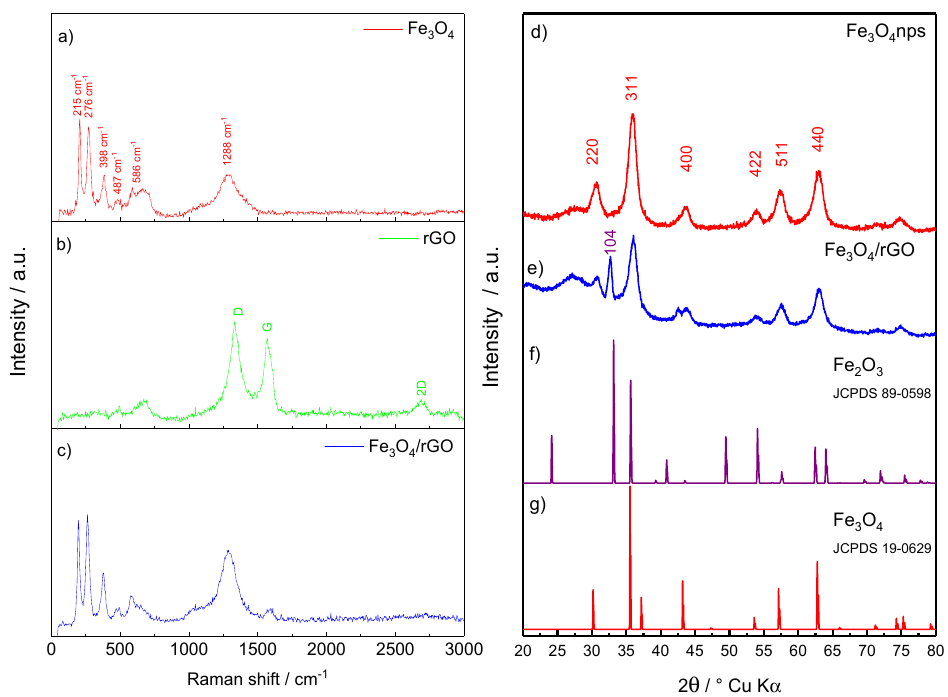
Figure 1. ( a ) Raman spectra of pristine Fe 3 O 4 nanoparticles, ( b ) rGO (red line), and ( c ) Fe 3 O 4 /rGO. X-Ray diffraction patterns of ( d ) Fe 3 O 4 nanoparticles and ( e ) Fe 3 O 4 /rGO; for reference, the JCPDS card of ( f ) Fe 2 O 3 (89-0598) and ( g ) Fe 3 O 4 (19-0629).